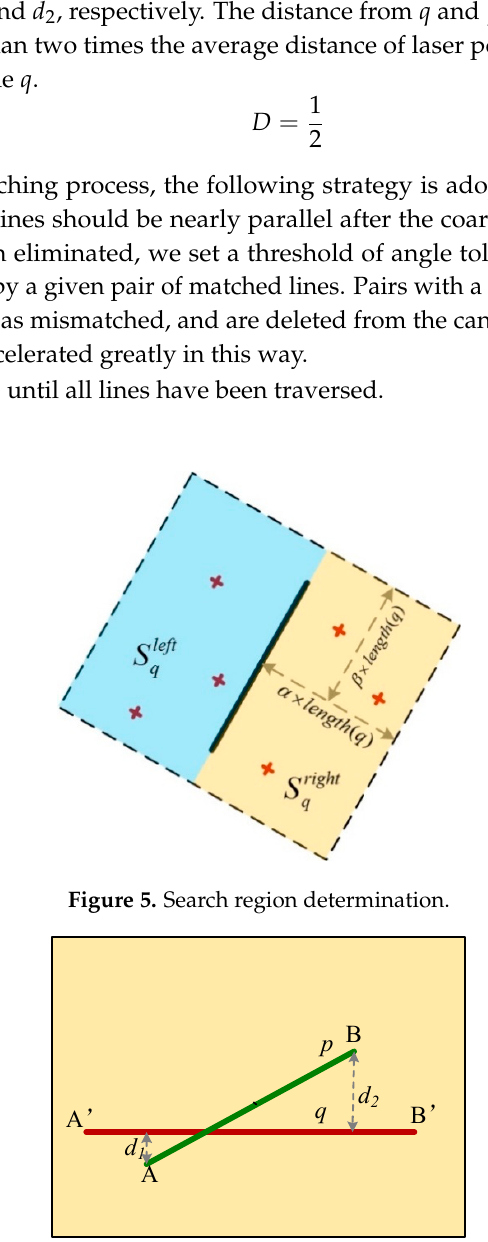
Figure 6. Distance between two straight line segments.